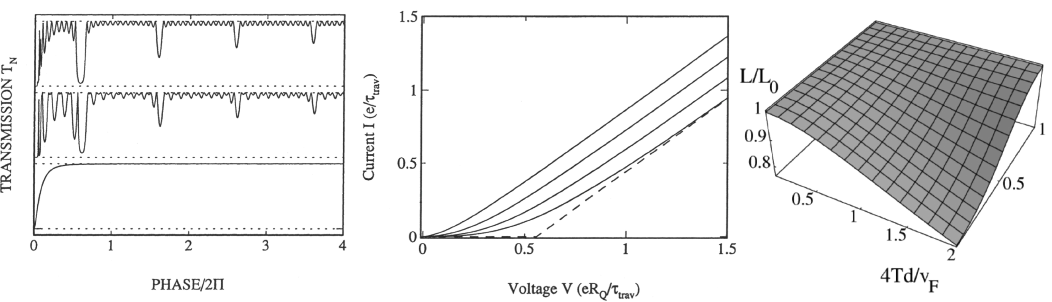
Figure 1: Left: The transmission of an array of 16 quantum dots (upper curve). The transmission of each barrier increases with the phase φ according to the lowest curve. The middle curve is obtained for a system with weak disorder [ 4 ] . Middle: The current (in units of e /τ ) through a constriction in series with a resistor R as trav s /τ a function of the voltage over the constriction in units of eR for (from left to Q trav / R = 0.5,1.0,1.5, and 2.0. τ right) R is the travel time through the constriction. s Q trav / R = 2.0 [ 4 ] . Right: The The dashed line is the high-voltage asymptote for R s Q Lorentz number for an ideal wire with interaction strength g at temperature T [ 10 ]